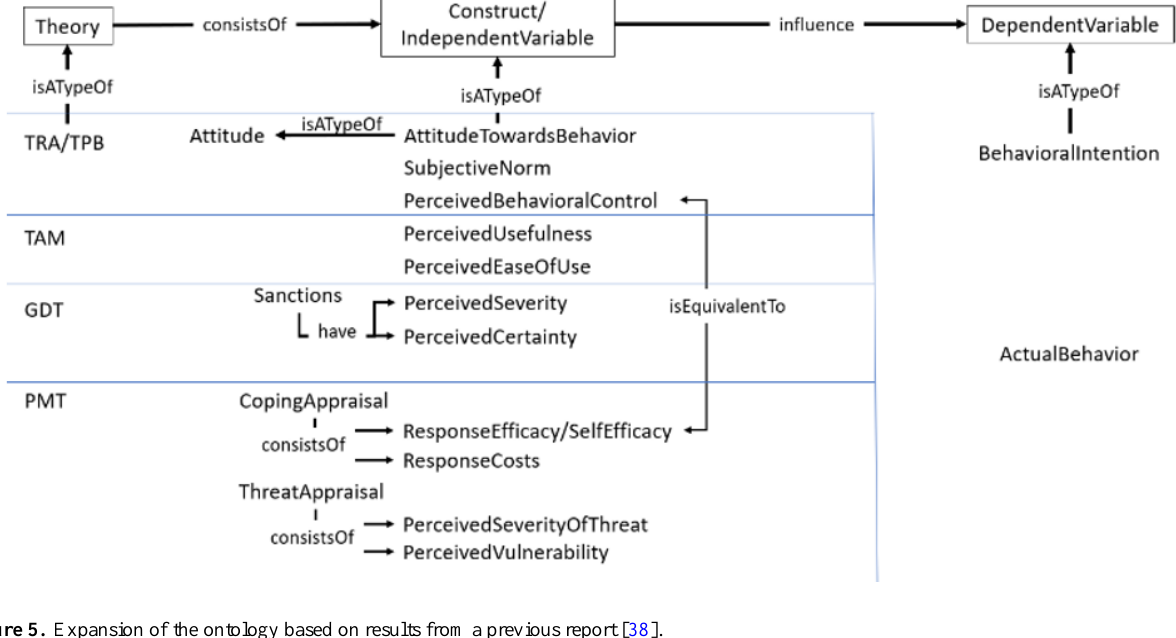
Figure 4. Instances and additional properties defined from the review paper [38]. GDT: general deterrence theory; PMT: protection motivation theory;